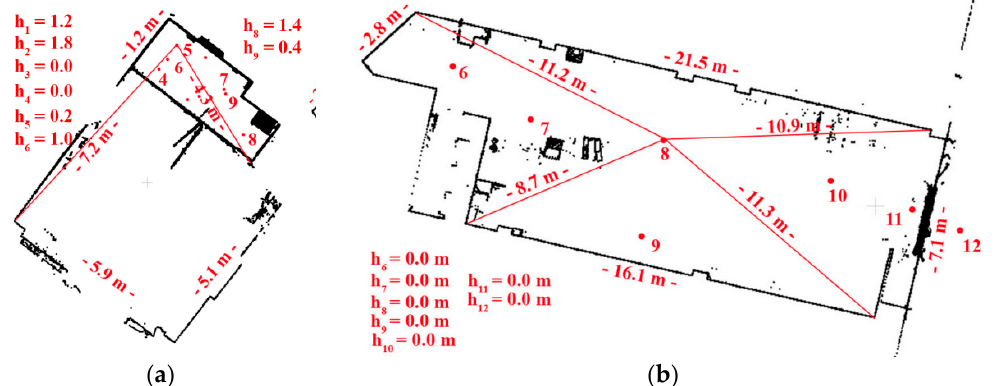
Figure 4. An example of the point cloud in the spherical projection of Test Site III: “The Office” with marked check points (red circles) [27].